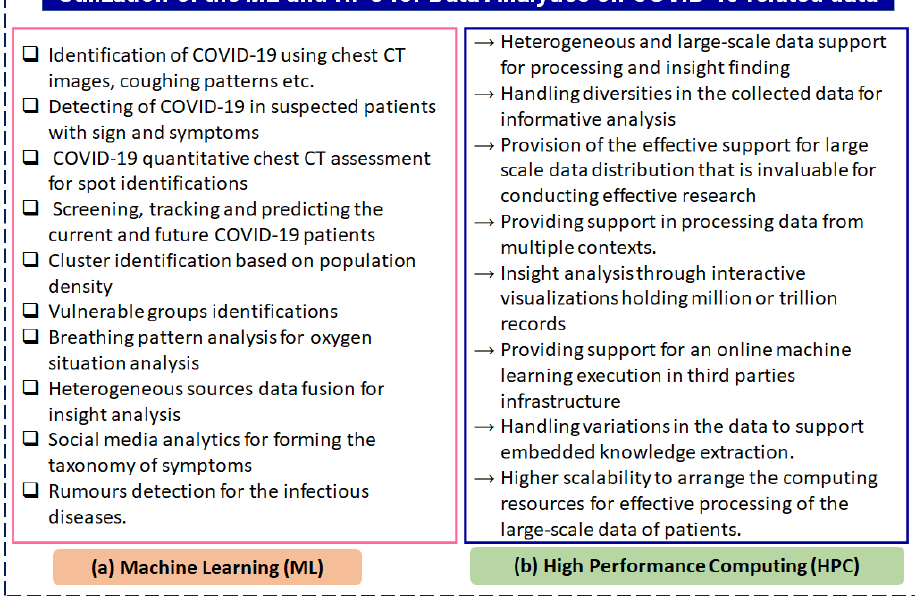
Figure 5. Role of ML and HPC in data analytics to fight with COVID-19 through